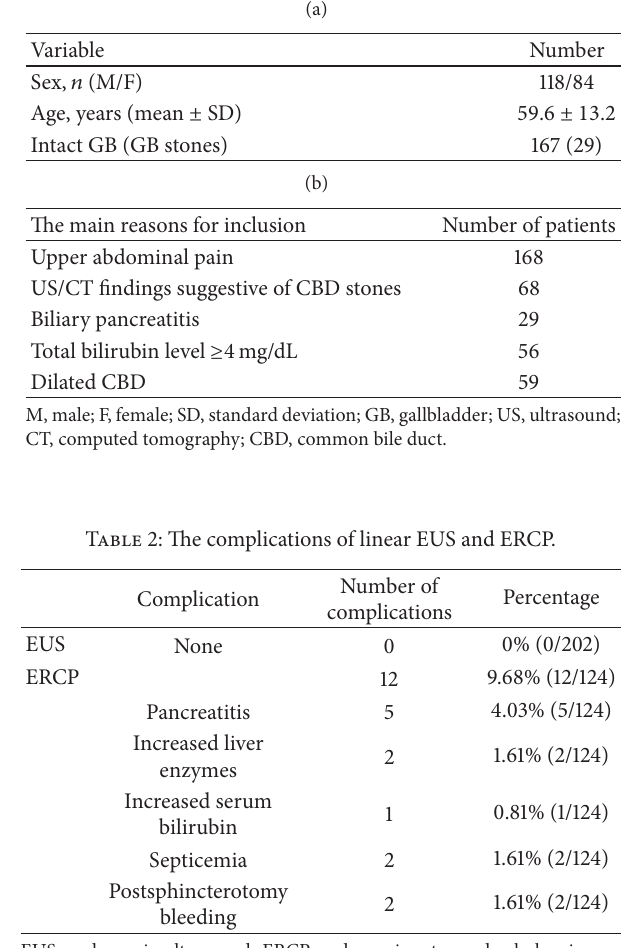
Table 1: Patient characteristics.